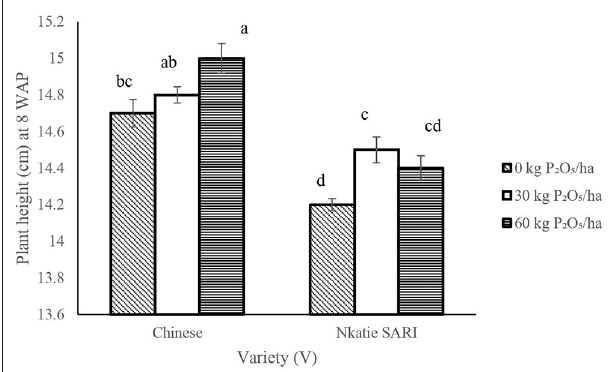
FIGURE 2 | Interactive effect of P-rate (PR) and variety on plant height (cm) of groundnut at 8 weeks after planting (8 WAP). Bars with different letters (in horizontal direction) show significantly different means. Error bars represent standard error of